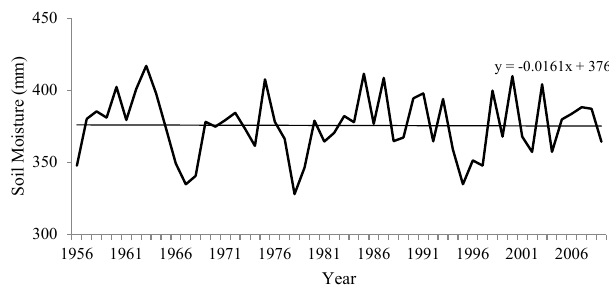
Fig. 5 Long-term change of SM3 in Jiangsu